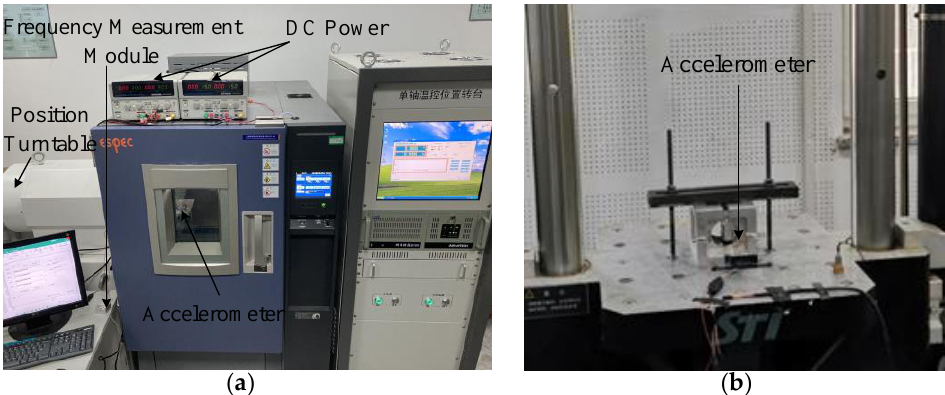
Figure 13. Photographs of experimental equipment: ( a ) single-axis temperature-controlled position turntable and ( b ) shock test apparatus.